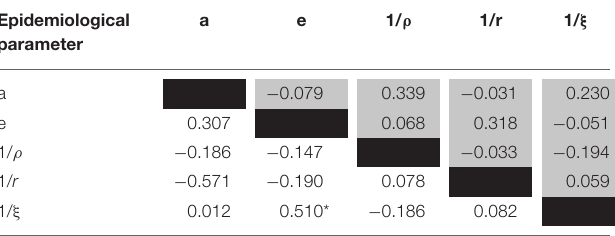
TABLE 4 | The matrix of correlations between the epidemiological parameters (observed values; white cells: high bacterial dose, gray cells: low bacterial dose; Spearman coefficients: * p <